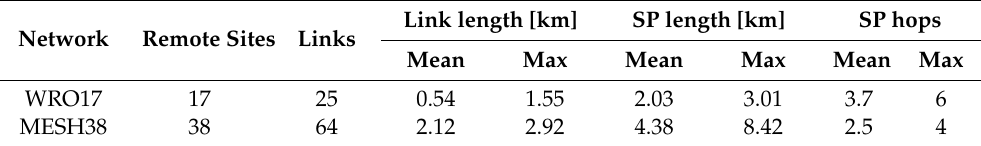
Figure 3. WRO17 and MESH38 network topologies showing fiber connectivity between remote sites (circles) and hub site (hexagon); the triangles in WRO-17 represent real antenna locations. Table 4. Characteristics of analyzed networks; SP denotes the shortest